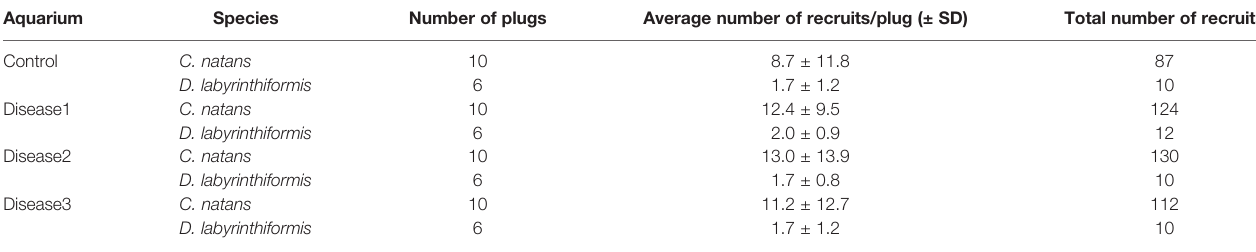
TABLE 1 | Experimental design showing number of plugs and recruits of each species allocated to each experimental aquarium. Aquarium Species Number of plugs Average number of recruits/plug (± SD)